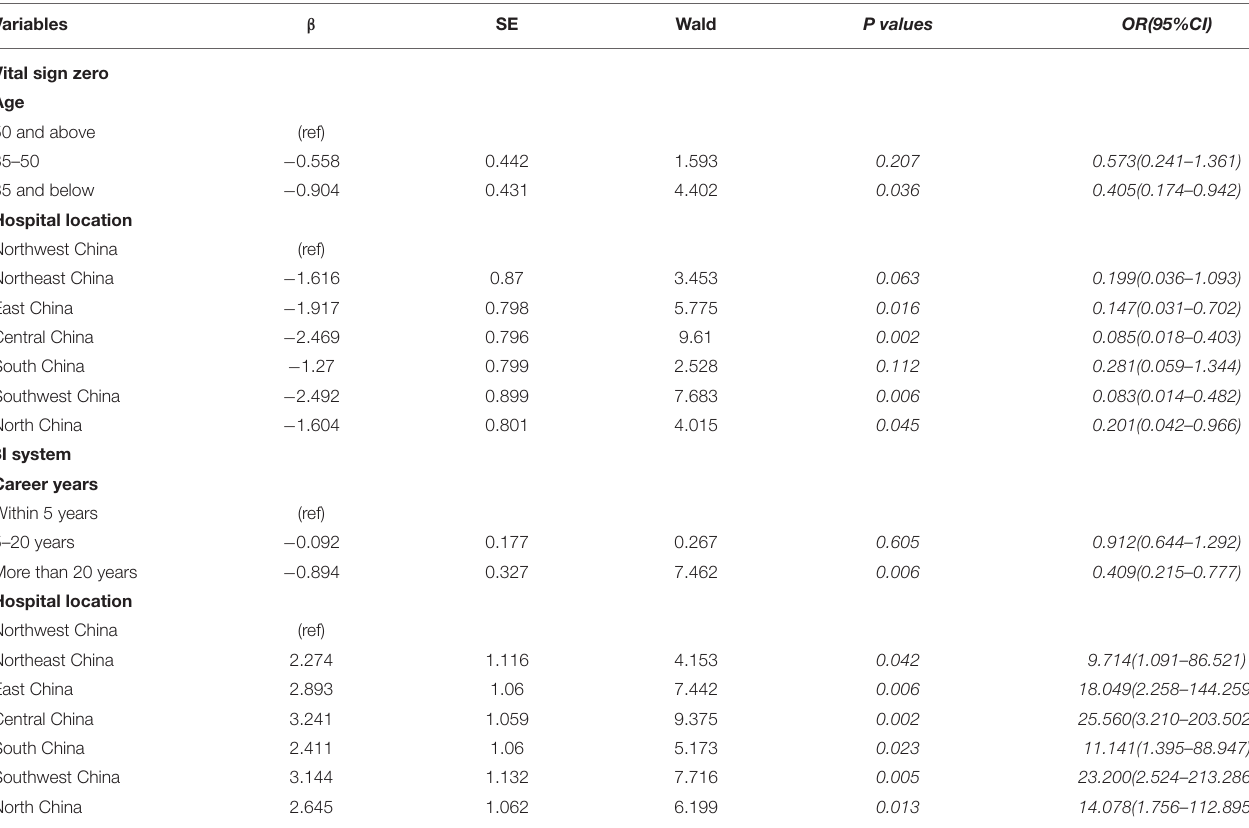
TABLE 5 | Logistic regression models of factors influencing the cognition of Vital sign zero and 3I system among health care workers from tertiary hospitals, China, 2021, ( N = 602).